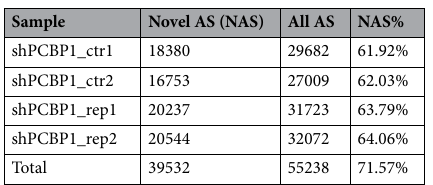
Table 3. All AS events detected from all samples. AS alternative splicing, PCBP1 poly C binding protein 1.